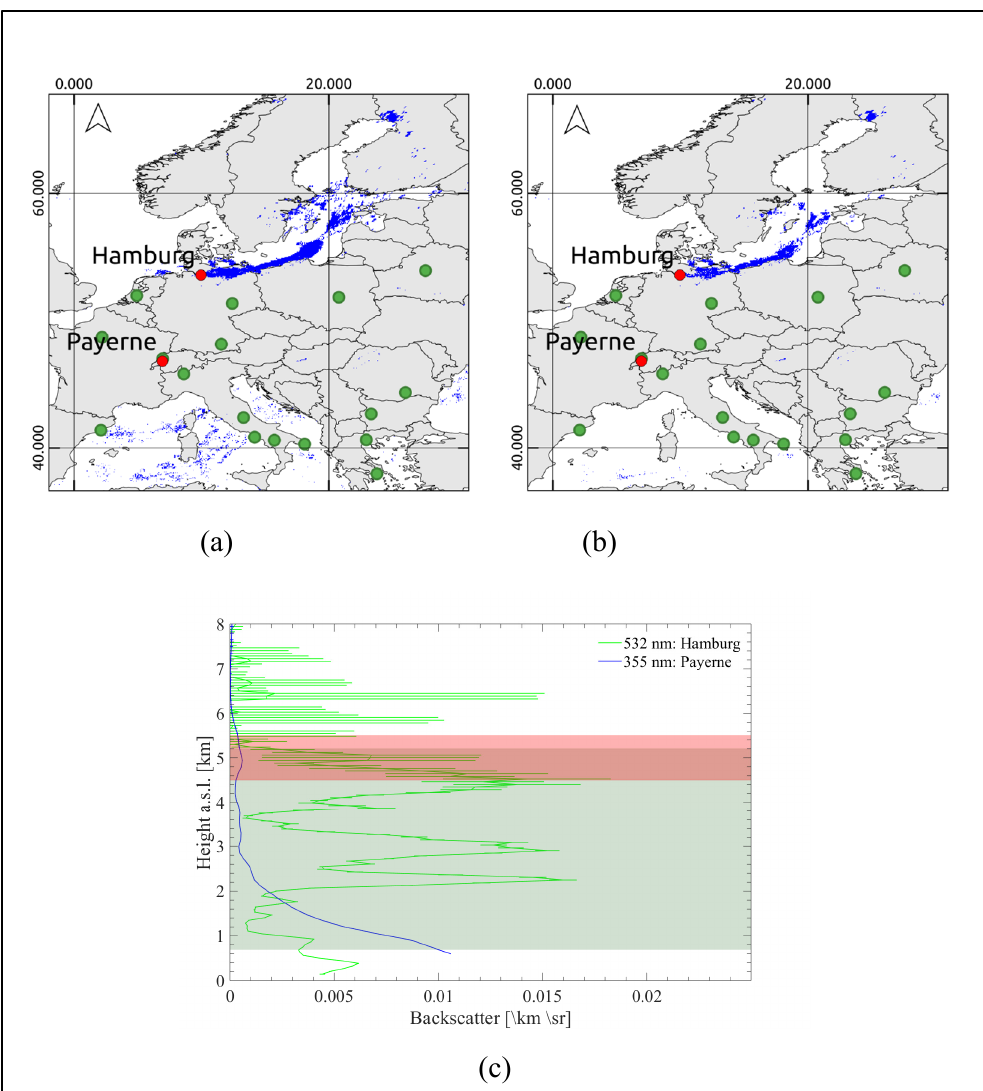
Figure 4. ( a ) Standard RST ASH product of April 16 at 06:00 UTC. ( b ) Tailored RST ASH product of the same day and hour generated using the algorithm arrangement described in section 2.2.1. EARLINET measurement stations revealing the presence of ash at the time of analyzed SEVIRI data are reported in red and in green sites where no information about the possible presence of ash was available. ( c ) Aerosol backscatter coefficient profile at 532 nm retrieved at the EARLINET station of Hamburg and at 355 nm retrieved at the EARLINET station of Payerne between 05:30–06:30 UTC. The green zone indicates the ash affected portion of the profile of the Hamburg station and the pink zone is referred at the profile of Payerne station.